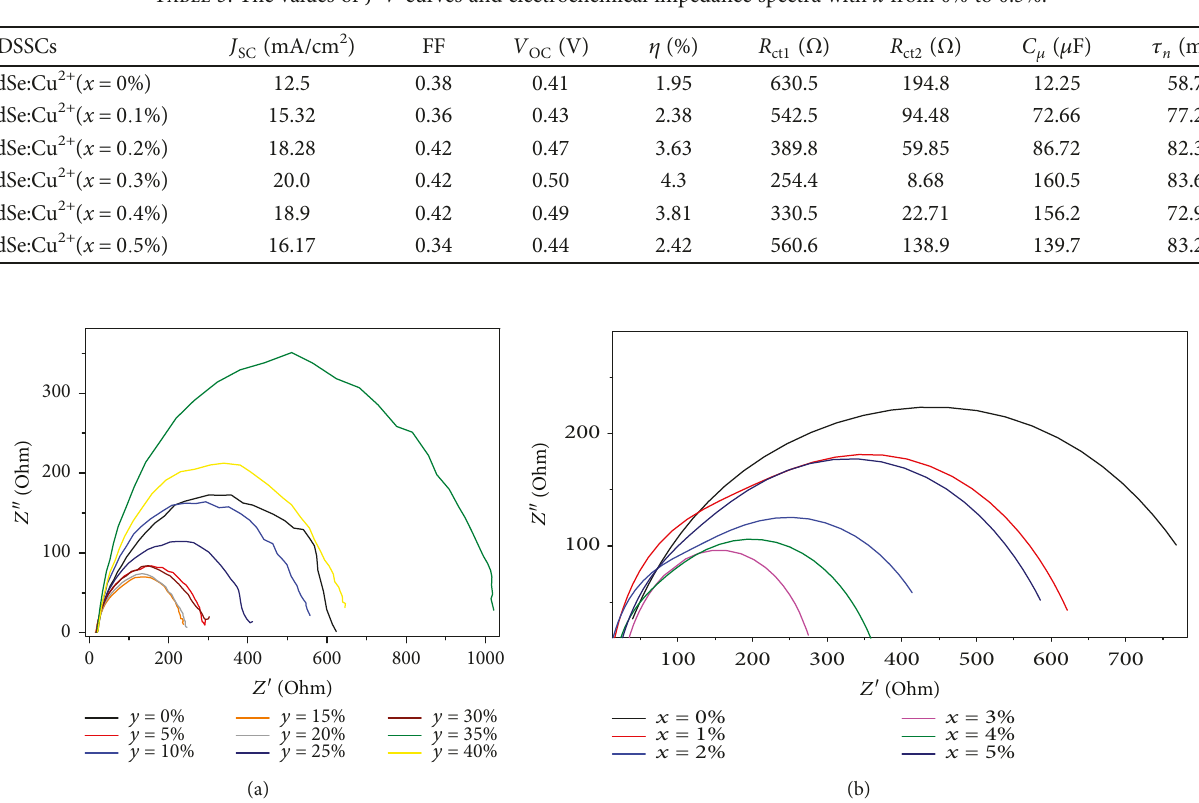
Table 3: The values of J - V curves and electrochemical impedance spectra with x from 0% to 0.5%.